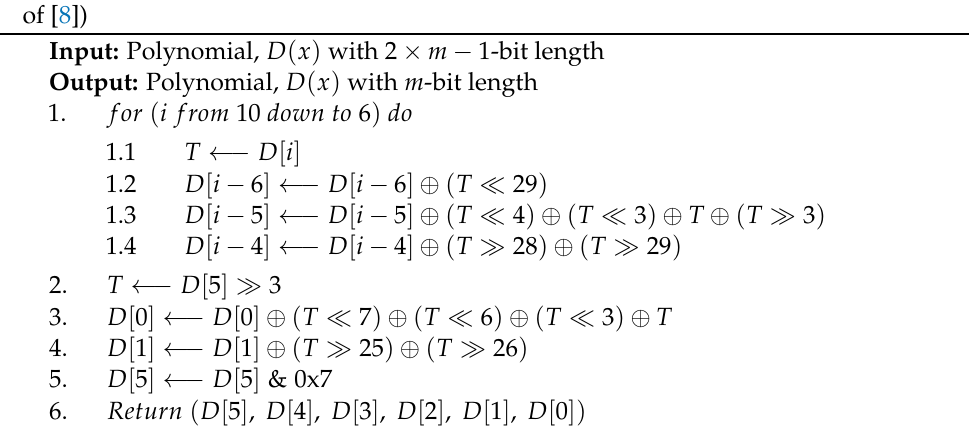
Algorithm A1: Polynomial Reduction Algorithm over GF ( 2 163 ) (algorithm 2.41